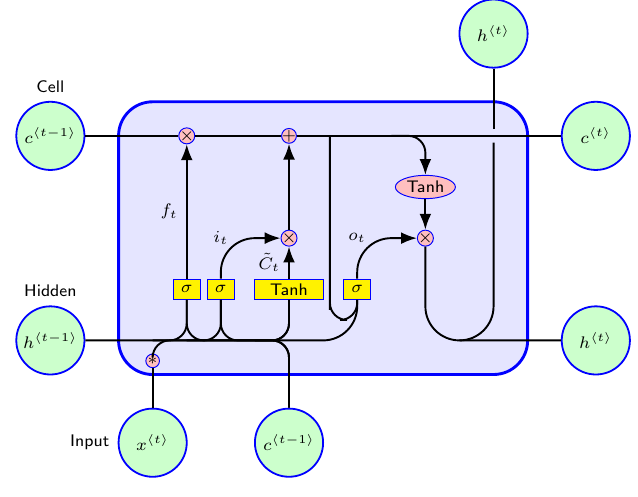
Figure 3. Inner structure of LRCN